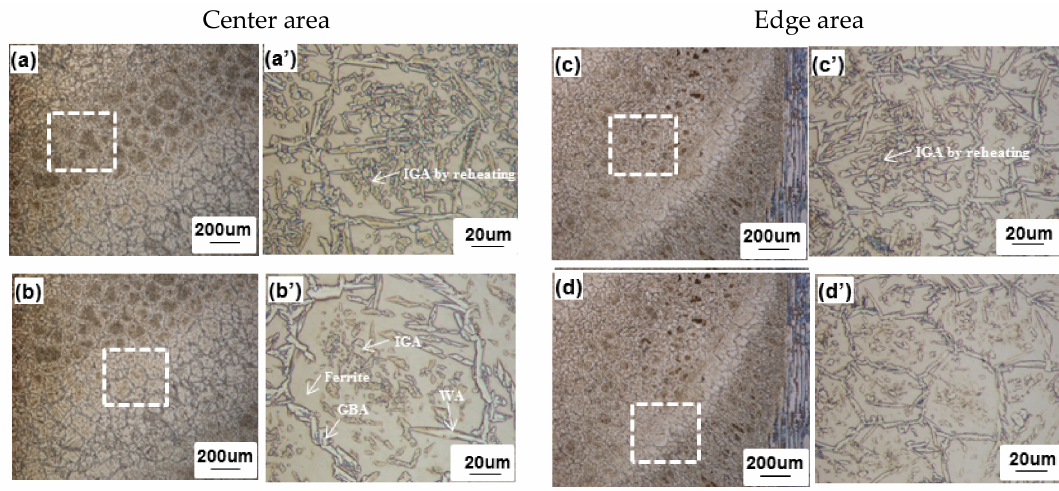
Figure 5. Microstructural analysis at the edge and the center of weld metal of low heat input; the center: ( a , a’ ) reheated weld metal (WM); ( b , b’ ) non-reheated WM; the edge: ( c , c’ ) reheated WM; and ( d , d’ ) reheating-free